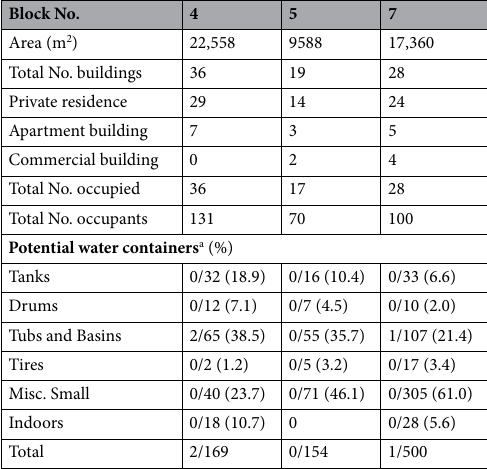
Table 1. Demographics for Treatment blocks in Curepe, Trinidad. a No. Positive containers/Total containers inspected, May 27–29, 2019. All containers present were counted irrespective of whether they contained water or not. Data were limited to households that were accessible for container